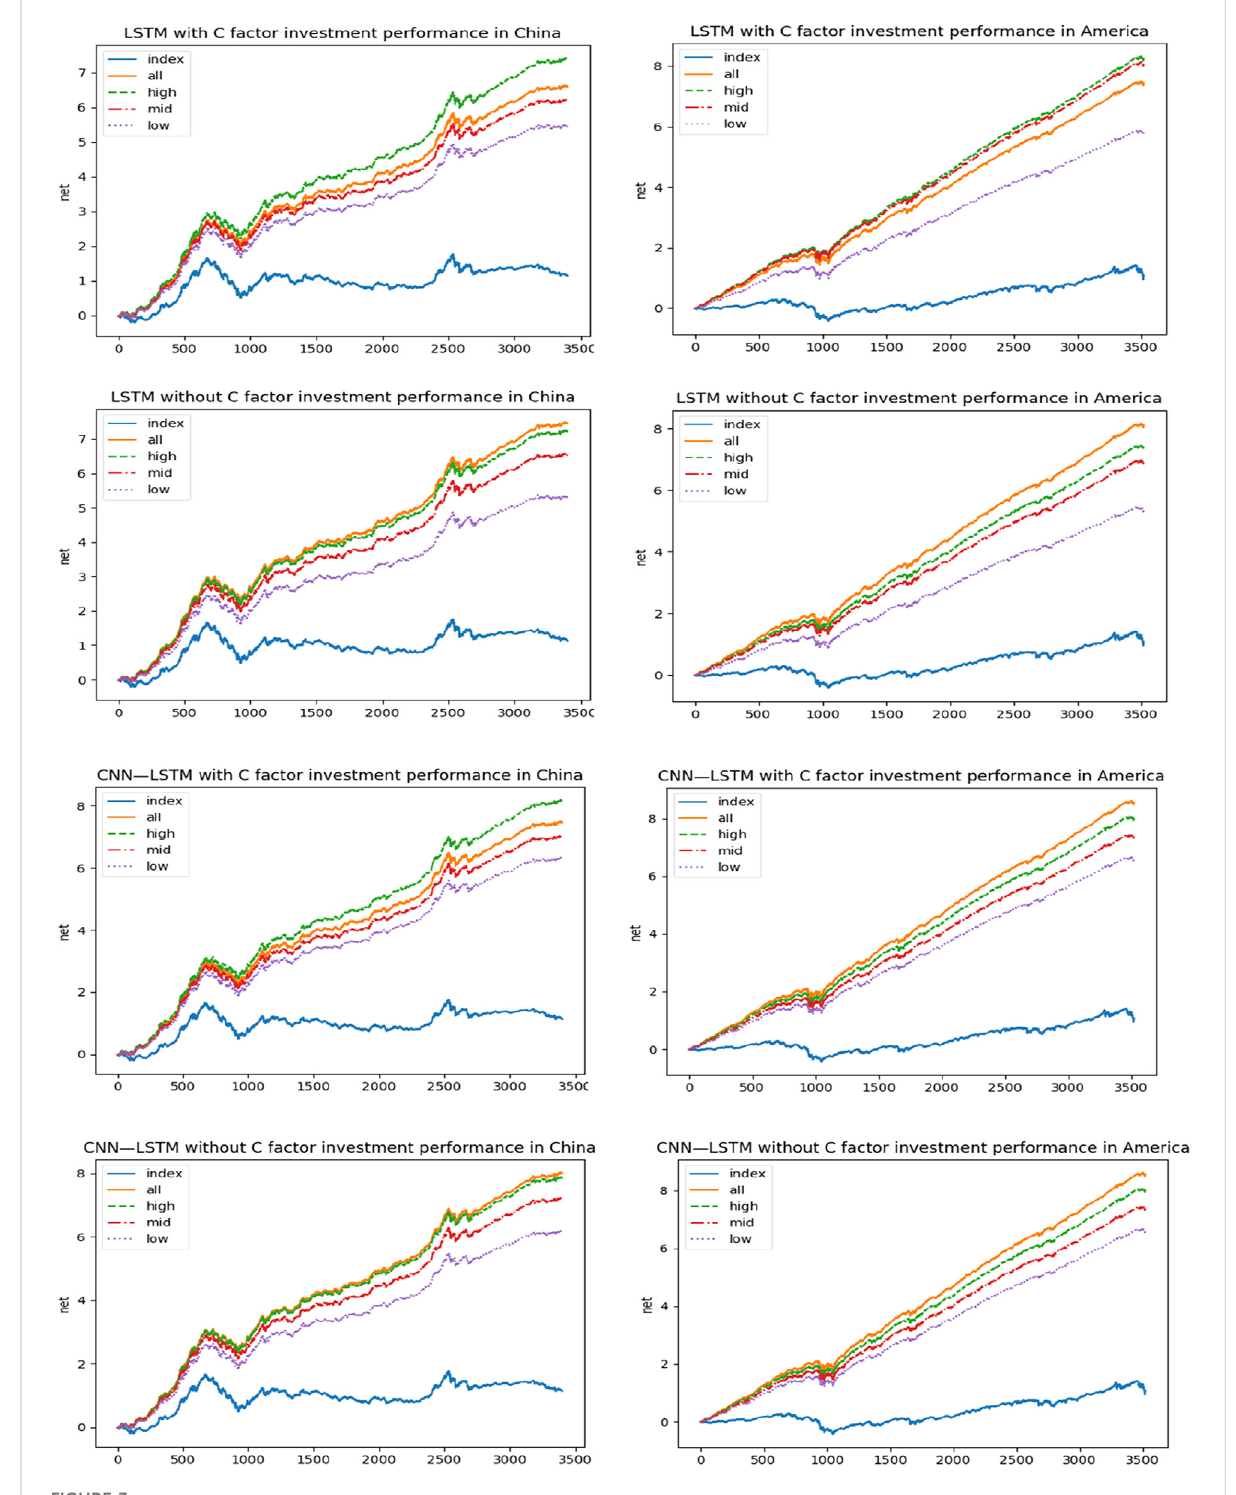
FIGURE 3 Cumulativereturn rateofportfolioconstructedbyMulti-LSTM method andCNN-LSTMmethod.Note: the fi gure shows thecumulativereturns from January 2005 to December 2018 of investment portfolios constructed by China and America through Multi-LSTM method and CNN-LSTM method with and without carbon factors in feature engineering. SSE Composite Index is selected as benchmark in China, while the S&P 500 is selected in America. In the legend, all stands for all stocks, high stands for high-carbon industry, mid stands for medium-carbon industry and low stands for low-carbon